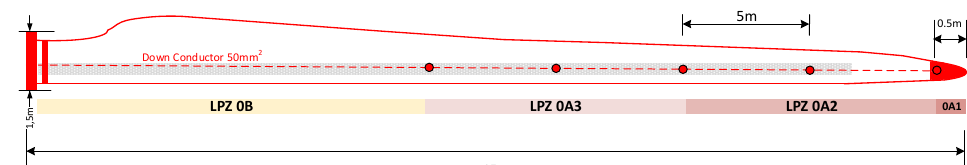
Figure 9. Conceptual blade design including standard and add-on III LPS.